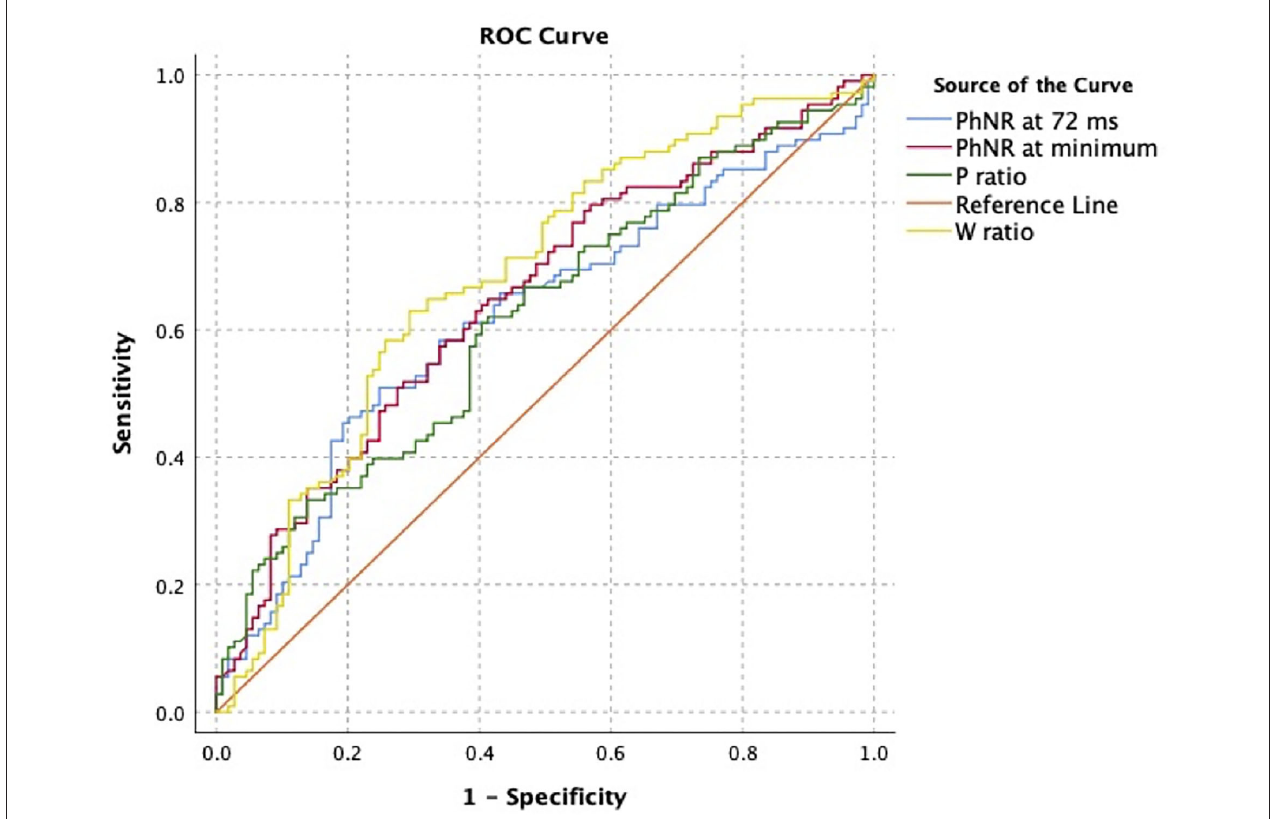
FIGURE 2 | Receiver operating characteristic analysis for classification of optic neuropathy status using user-defined electroretinogram (ERG) features. Curve was constructed using one eye per subject.